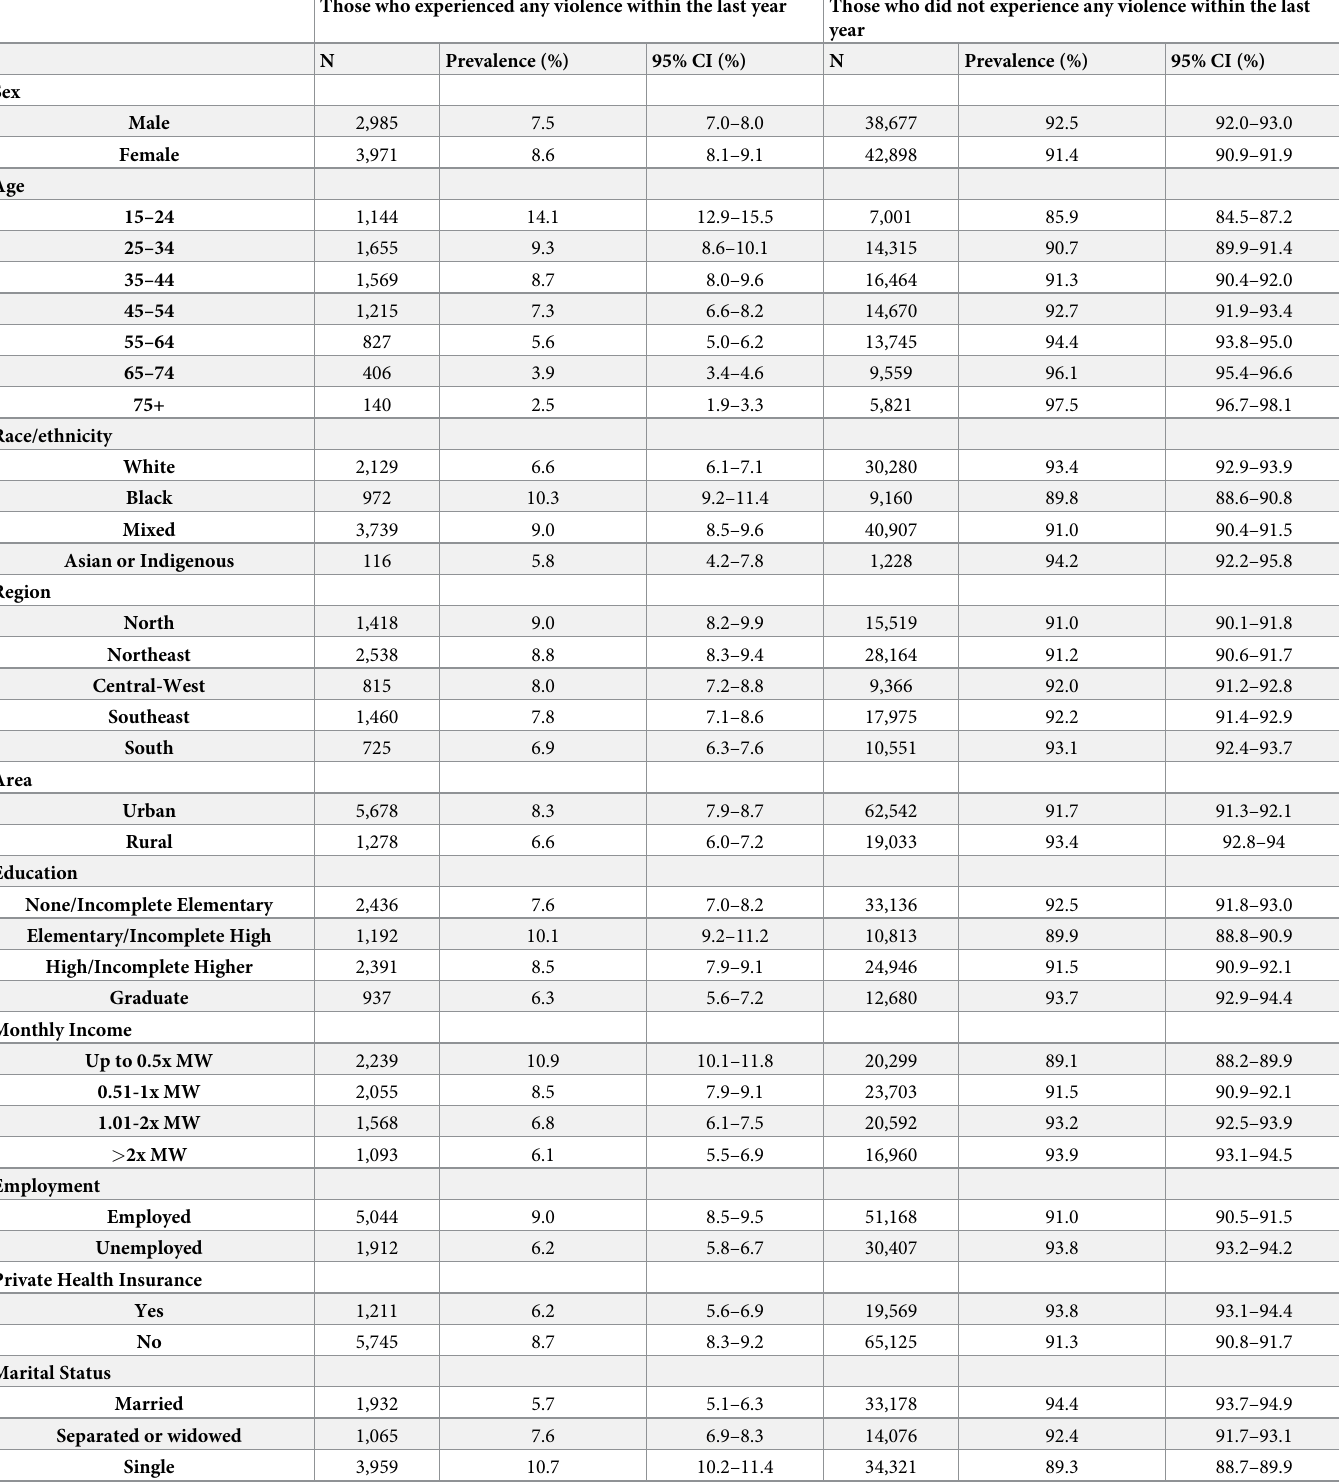
Table 1. Characteristics of survey respondents by experience of